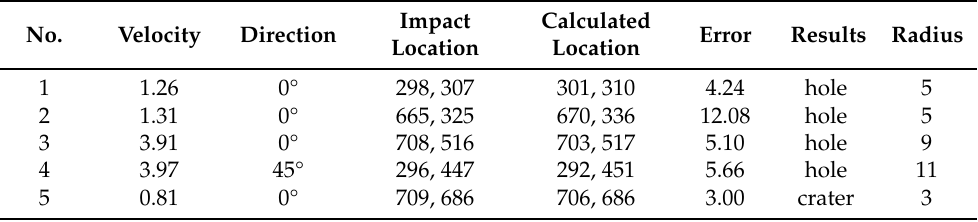
Figure 14. The photos of hypervelocity impact results. Table 3. Error analysis for the different locations (unit: